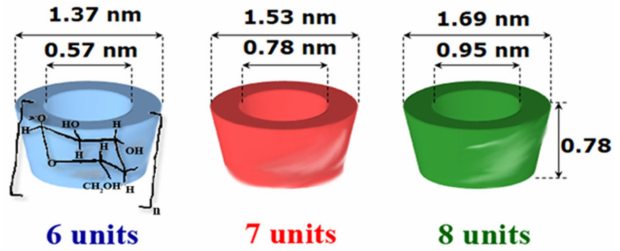
Figure 1. Structure and shape of native